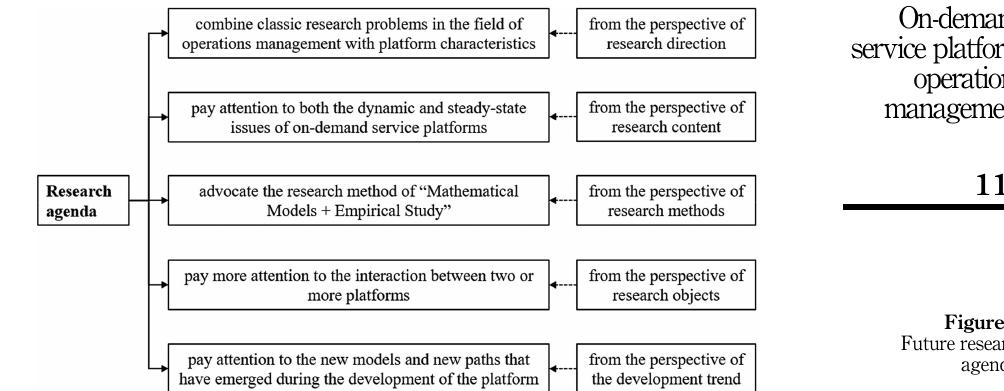
Figure 6. Future